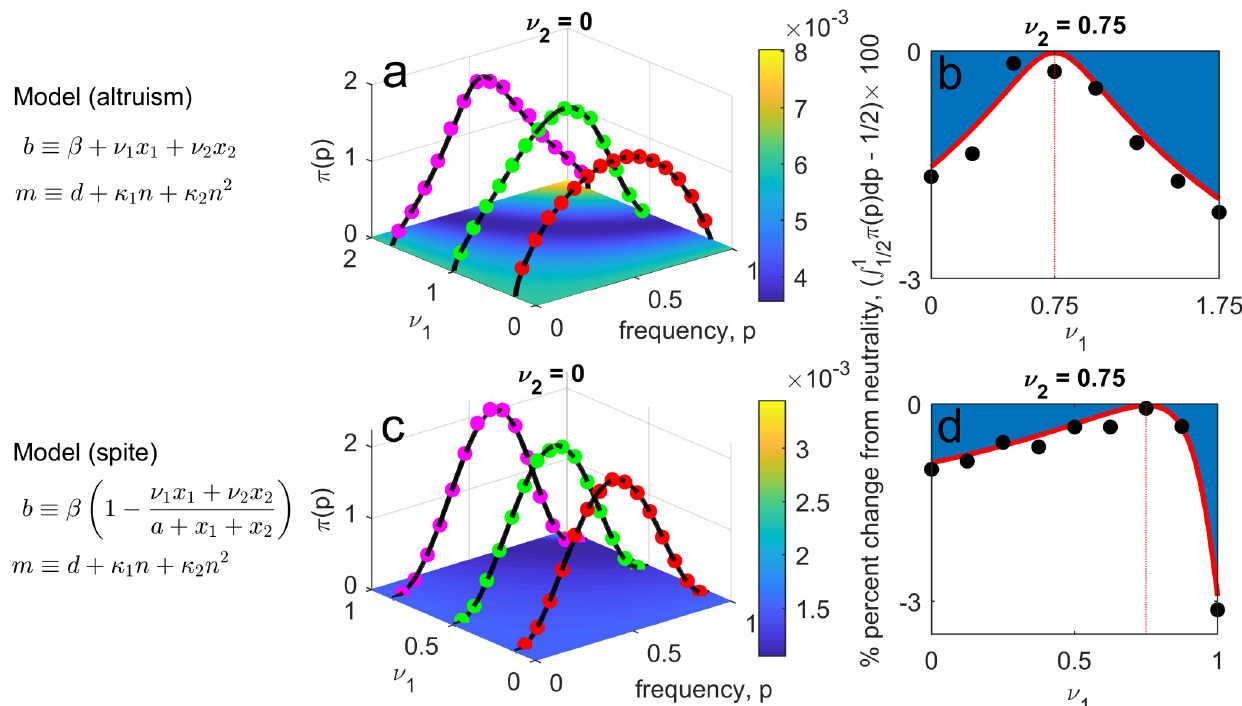
Fig 2. Role of demographic stochasticity in the evolution of cost-free social traits acting on birth rate. In subplots a - b , the social trait is altruism. In subplots c - d , the trait is spite. Subplot a —stationary distributions corresponding to three different strengths of altruism ν , showing how altruism can be disfavoured. Subplot c —stationary distributions corresponding to three different strengths of spite ν , showing how spite can be favoured. Underlying contour plot shows the value of the ratio T ( p )/[ O n ( p )].Subplots b,d show that in some cases an intermediate level of social action is optimal. Subplot b —a type that uses the intermediate level of altruism that minimizes the ratio T ( p )/ n ( p )in a monomorphic population (in this case ν = 0.75) is favoured over all other levels of altruism. Subplot d —a type that uses the intermediate level of spite that minimizes the ratio T ( p )/ n ( p )in a monomorphic population (in this case ν = 0.75) is favoured over all other levels of spite. Curves are analytic predictions and each circle is 6 × 10 4 simulations of the full stochastic process; simulations were run for 10 3 and 5 × 10 4 time units for subplots b and d respectively. Parameters values: { β , d , κ 1 , κ 2 , O , μ } = {1, 0.5, 0.75, 0.01, 250, 0.01} (subplots a - b ) and { β , d , a , κ 1 , κ 2 , O , μ } = {8, 1, 0.05, 0.05, 0.2, 900, 0.005} (subplots c - d